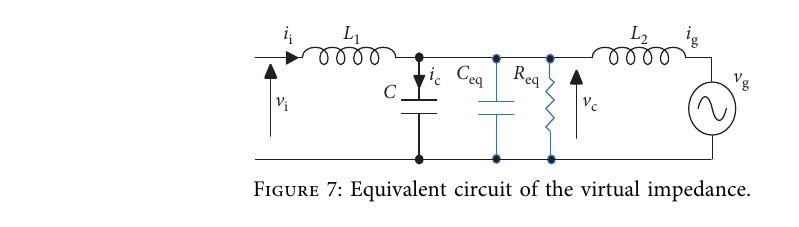
Figure 6: Block diagram of the control system with equivalent virtual impedance of the AD loop.